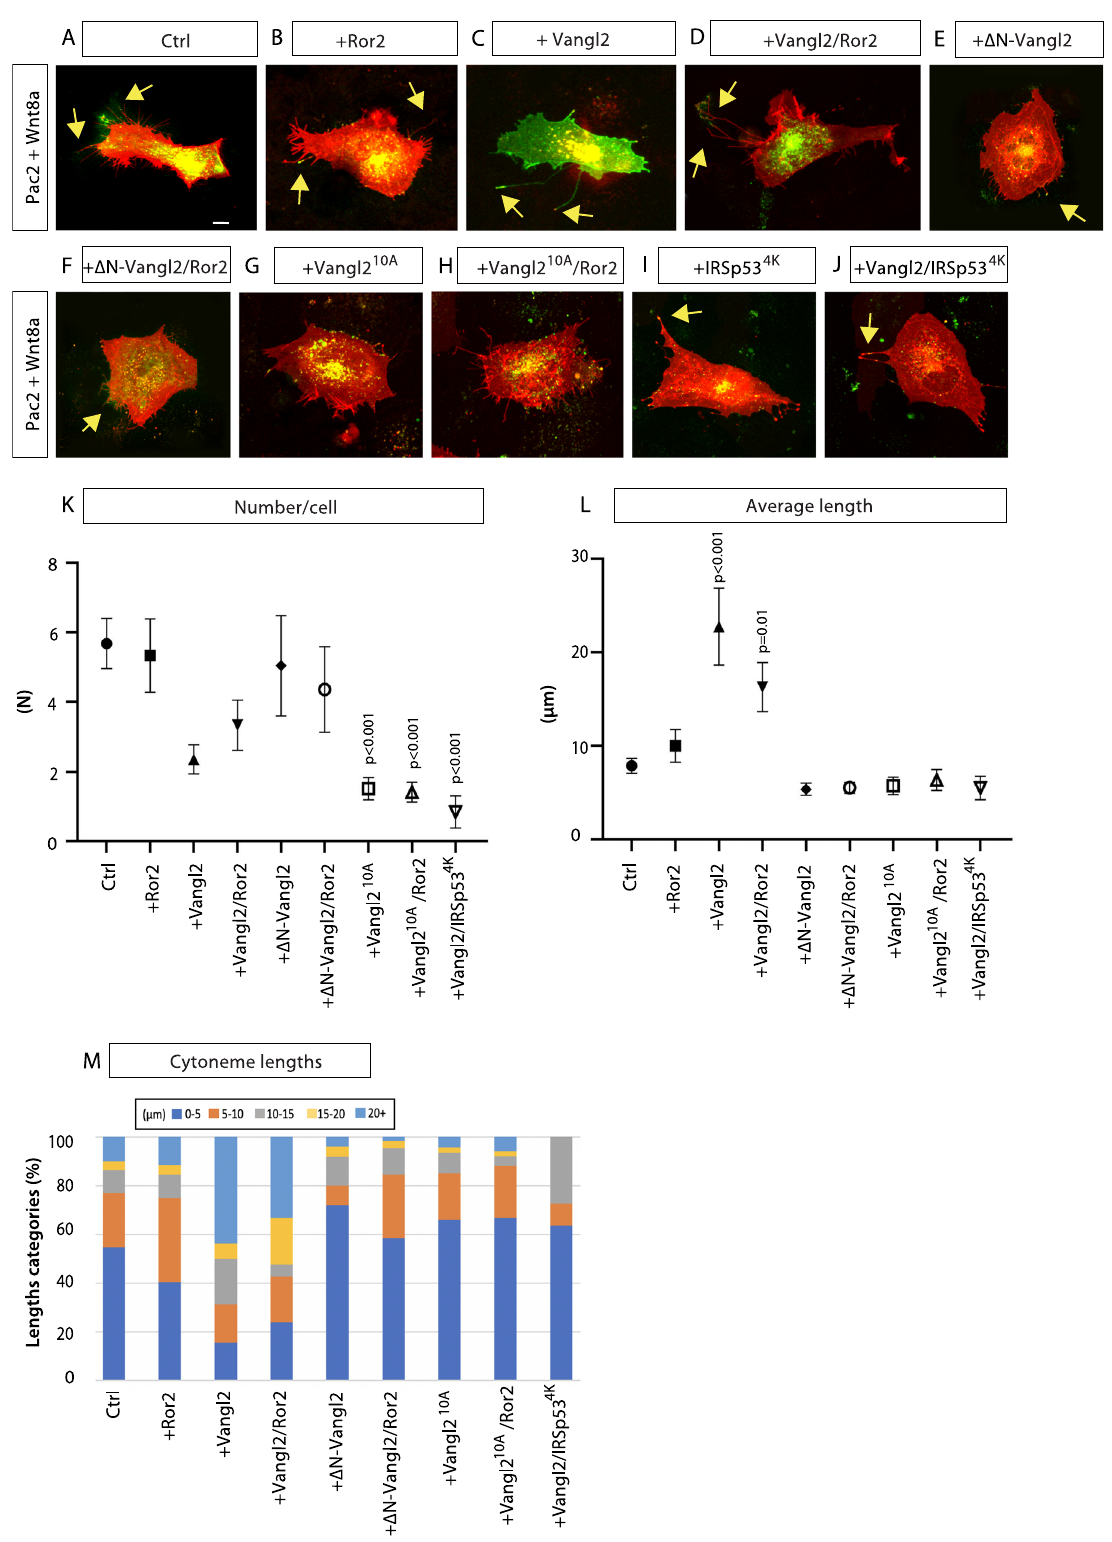
Fig. 2 Vangl2 controls the emergence of Wnt8a cytonemes in fi broblasts. A – J Wnt8a-positive PAC2 zebra fi sh fi broblasts transfected with indicated constructs, imaged and analysed live 24 h of post-transfection. Yellow arrows indicate examples of Wnt8a positive cytonemes. Scale bar = 10 µ m. K Number of Wnt8a positive cytonemes per cell ( n = number). ( n per condition = 25, 9, 14, 6, 25, 14, 31, 36, 13 cells). L Length of Wnt8a positive cytonemes in PAC2 cells ( µ m). ( n per condition = 139, 52, 32, 21, 131, 65, 47, 51, 11 cytonemes). M Breakdown of the percentage of Wnt8a positive cytoneme lengths into 0 – 5, 5 – 10, 10 – 15, 20 + µ m categories. Graphs represent mean and standard error of the mean. K , L Two-sided Kruskal – Wallis tests with Bonferroni correction for multiple tests. Statistical signi fi cance: p ≤ 0.05. SEM = 1. Corresponding dot plots are shown in Supplementary Fig. 2, and analysis of PAC2 fi lopodia is shown in Supplementary Figs. 3 and 4. Source data are provided as a Source Data fi